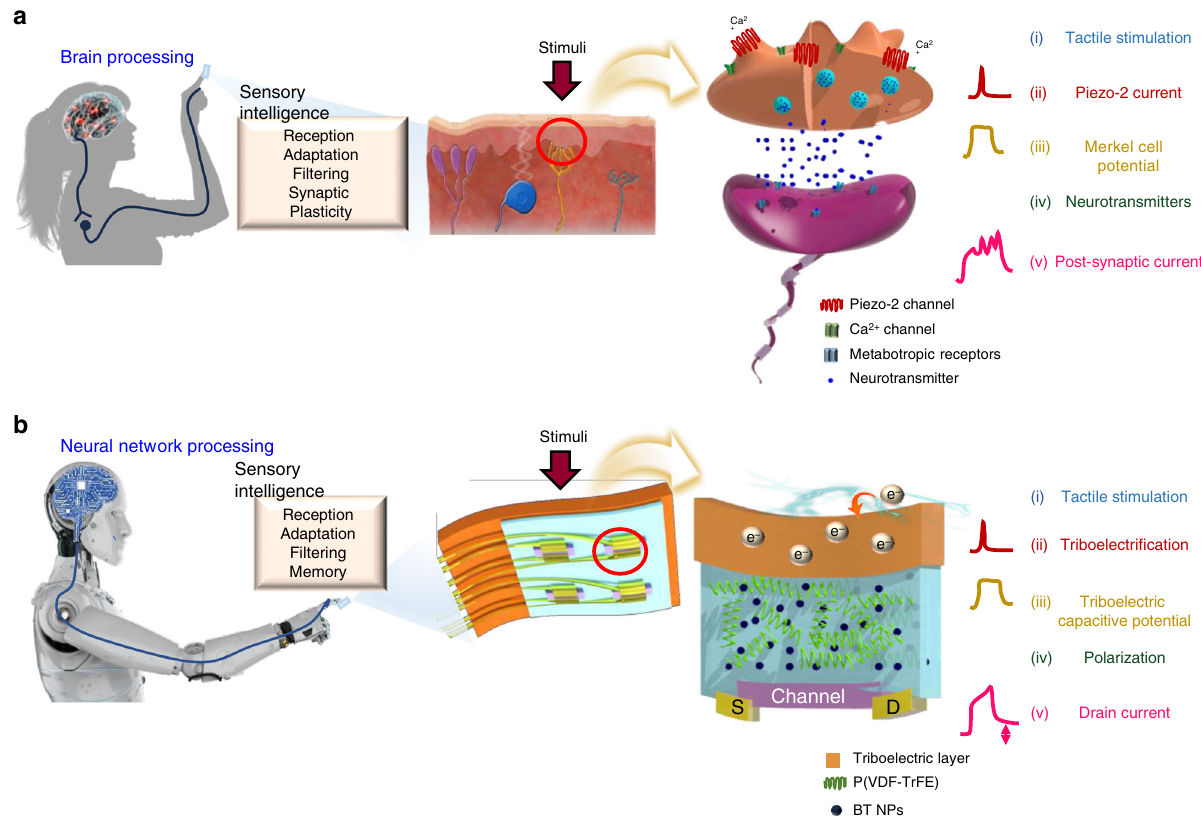
Fig. 1 Merkel cell-neurite complex and arti fi cial, intrinsic-intelligent tactile sensory organ (AiS-TSO). a Sensation and processing of stimuli by a sensory organ comprising a Merkel cell and neuron. The MCNC comprises the slowly adapting (SA) sensing mechanism of a Merkel cell and a synapse-like connection with an afferent neuron. Pressure induces in fl ux of Ca 2 + through the Piezo-2 channel into the Merkel cell, increasing membrane potential. The increase in membrane potential is prolonged because a Merkel cell has a high membrane resistance, which contributes to SA synaptic fi ring through release of neurotransmitters. SA fi ring occurs in response to tactile information and is processed by synaptic plasticity. b Reception by a fl exible AiS-TSO occurs in a self-energy transducing way by triboelectri fi cation during fi nger touch. Triboelectri fi cation induces tribo-charge pumping in the receptive part, which generates a triboelectric capacitive potential. Drain current is modulated with aligned dipoles in the BT NPs/P(VDF-TrFE) nanocomposite by generated triboelectric capacitive potential, resulting in a SA signal with synaptic properties. The same colors in a , b indicate corresponding functions of the MCNC and AiS-TSO